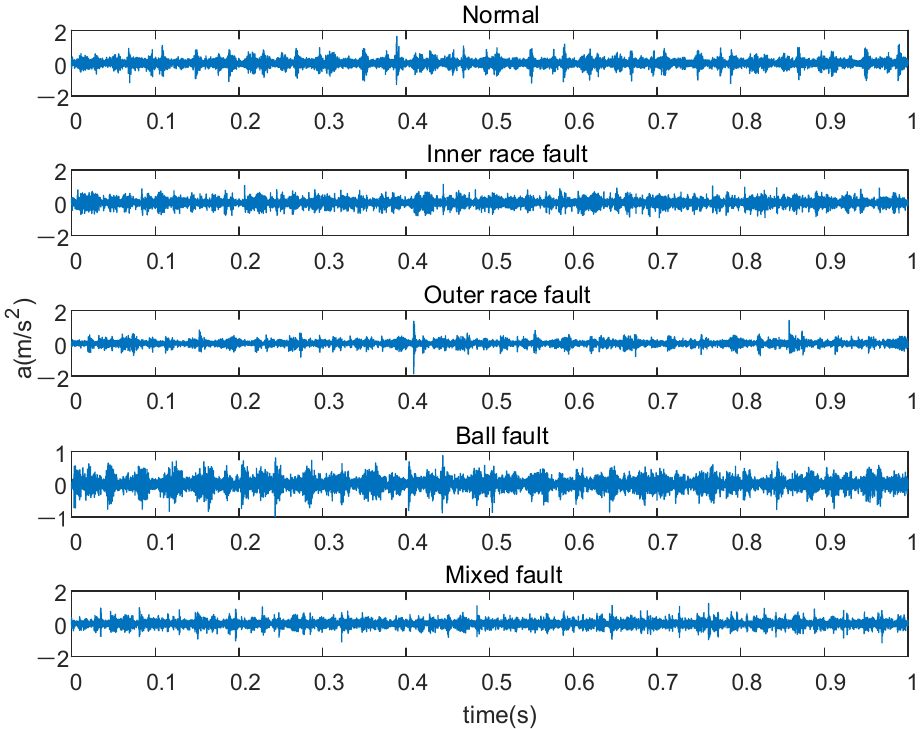
Figure 10. Original vibration signals.